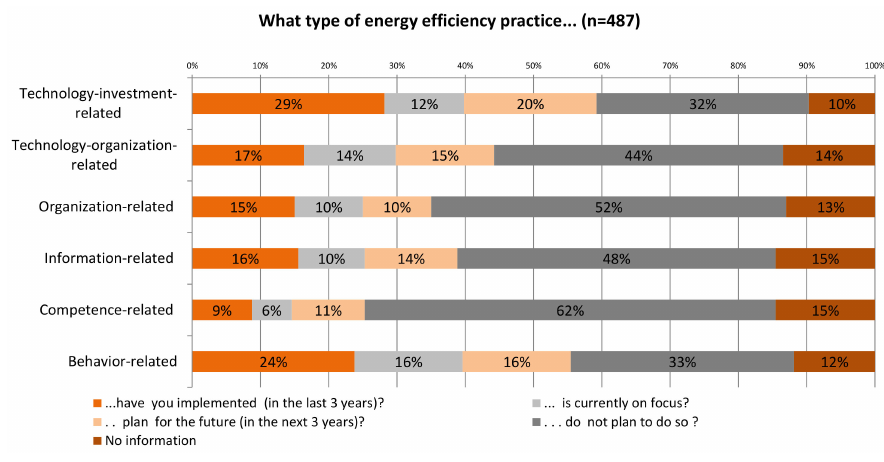
Figure 6. Importance of di ff erent types of